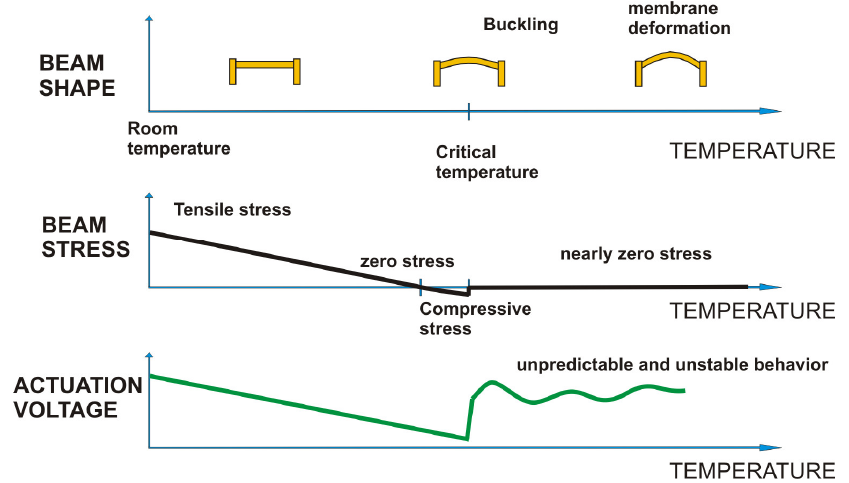
Figure 4. Scheme of the interrelation between temperature, beam shape, internal stress, and actuation voltage in a clamped–clamped beam. The precise value of the critical temperature depends on the beam’s geometry and material.